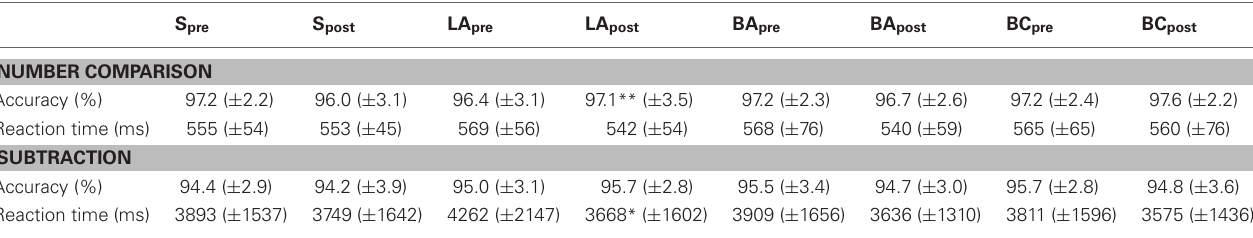
Table 1 | Effects of tDCS on accuracy and reaction times in Experiment